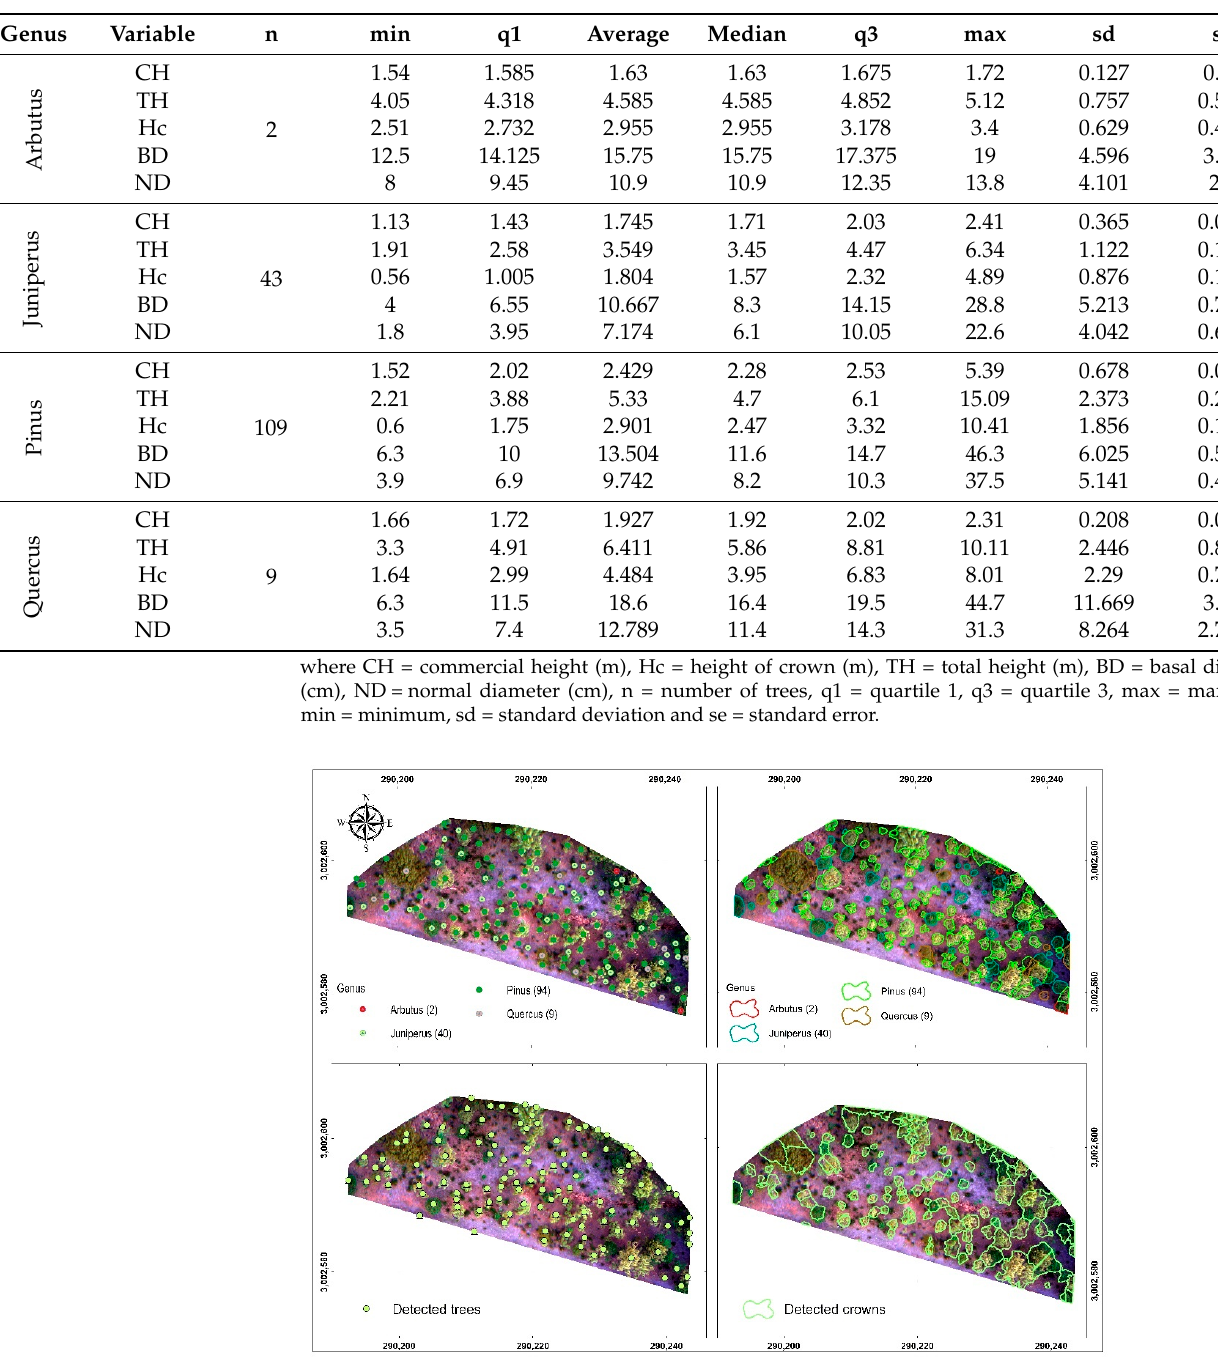
Table 2. Statistical description of the trees recorded in “El Cordoncito”.